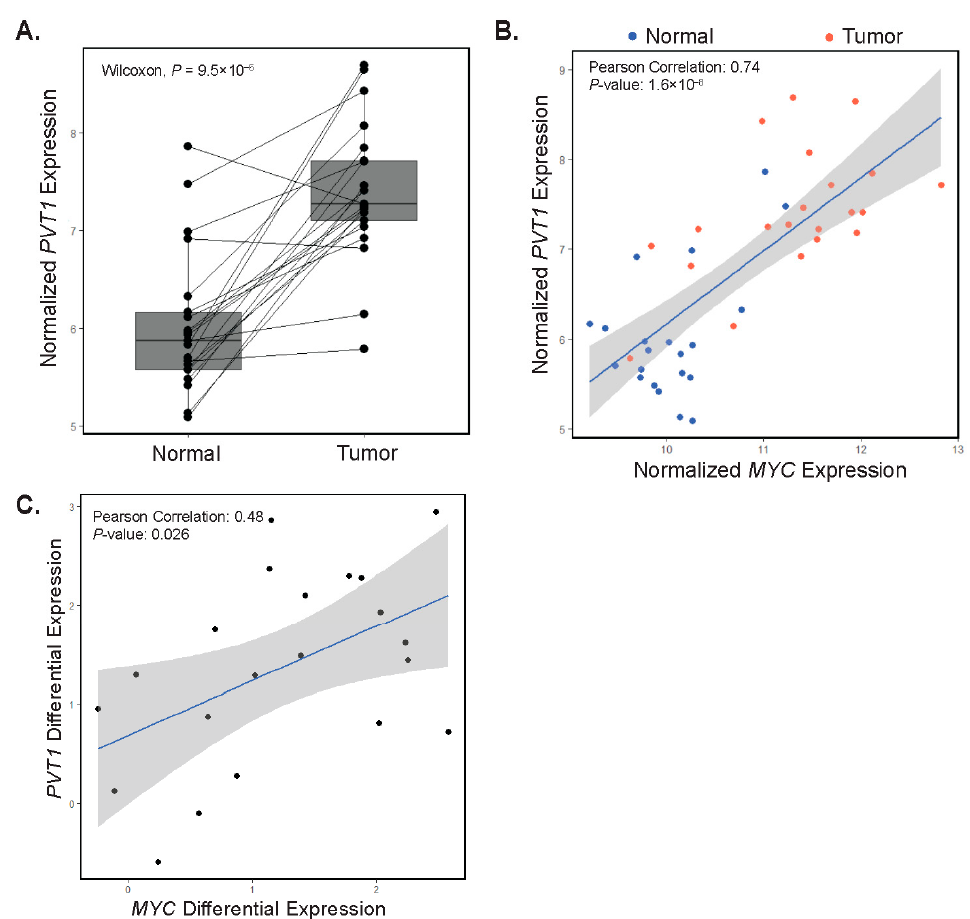
Figure 5. Expression of PVT1 correlates with MYC expression. ( A ) rlog normalized expression plot of PVT1 in patient-matched adjacent colonic tissues (Normal) and tumors (paired Wilcoxon test, p = 4.8 × 10 − 6 ). Each point represents a single patient with a line drawn between matched samples. ( B ) Correlation plot depicting normalized MYC versus normalized PVT1 gene expression in adjacent colonic segments (Normal, blue points) and tumors (red points). ( C ) Correlation plot depicting PVT1 and MYC differential expression in patient-matched adjacent colonic segments and tumors.